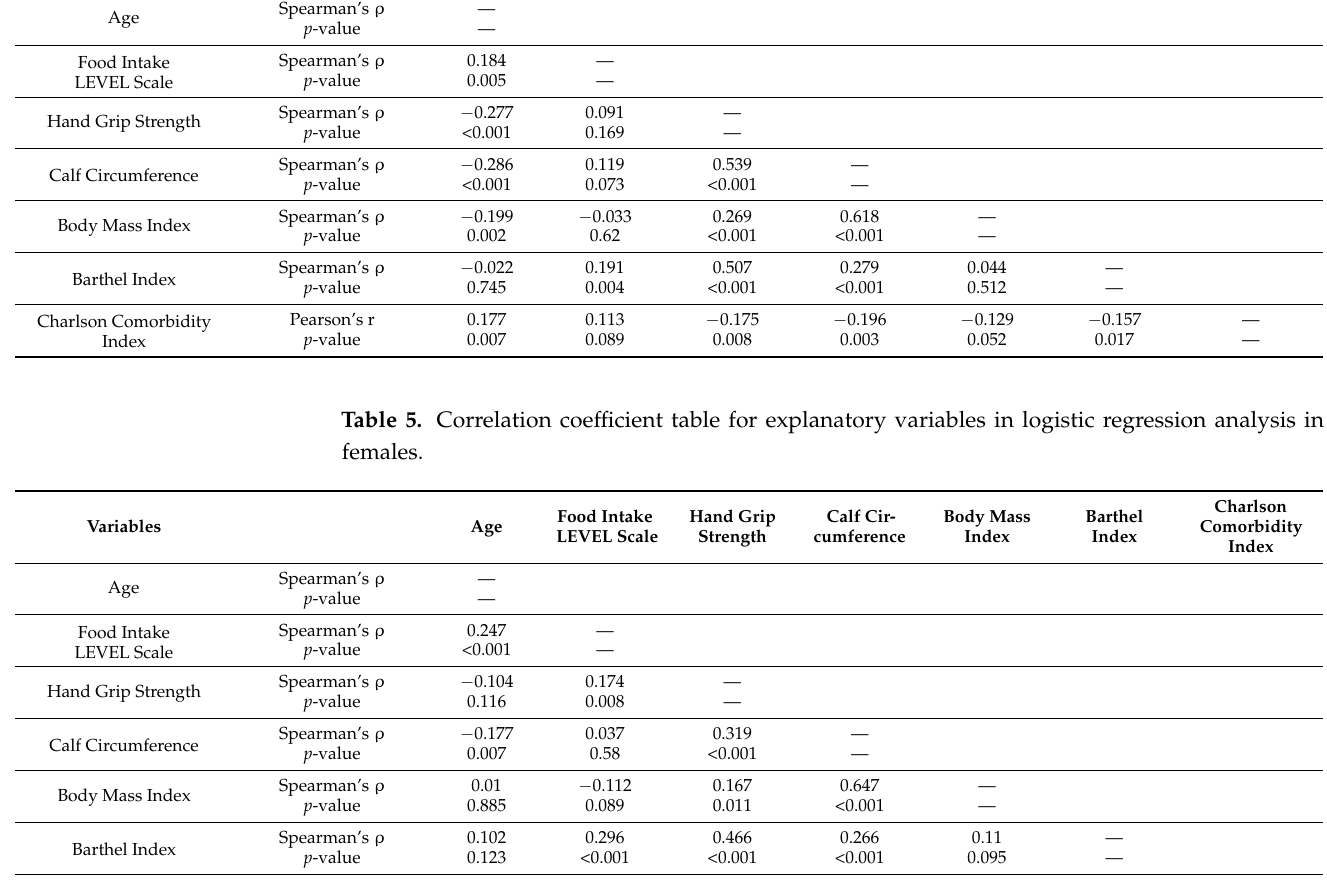
Table 4. Correlation coefficient table for explanatory variables in logistic regression analysis in males.